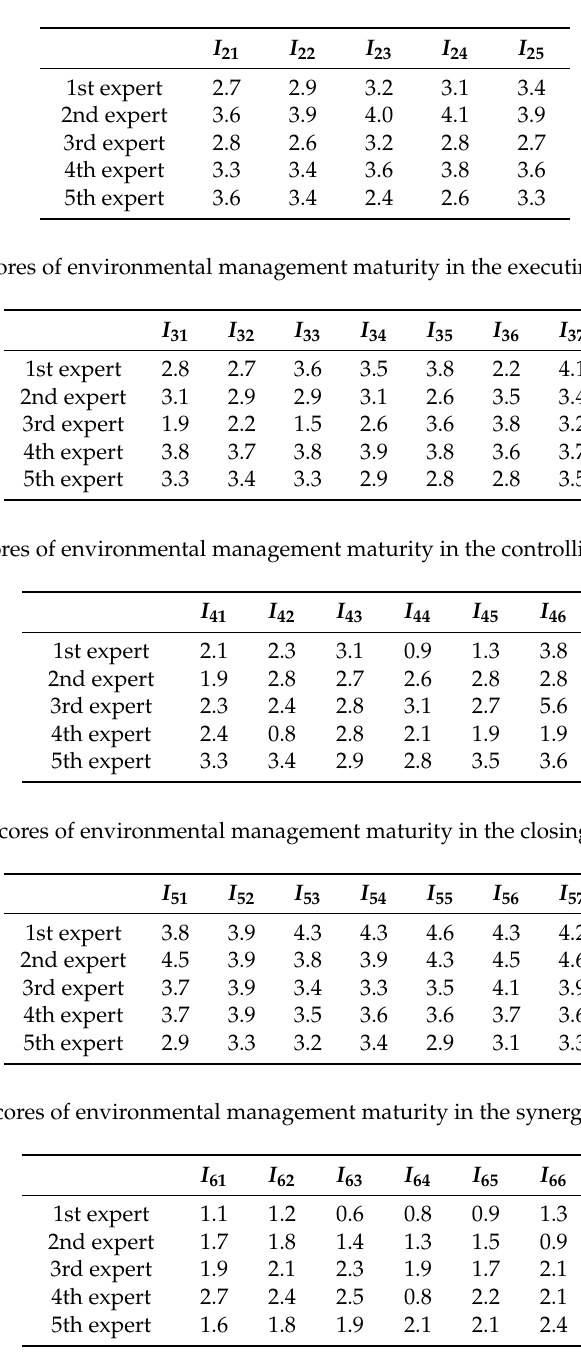
Table A18. Scores of environmental management maturity in the planning process index.